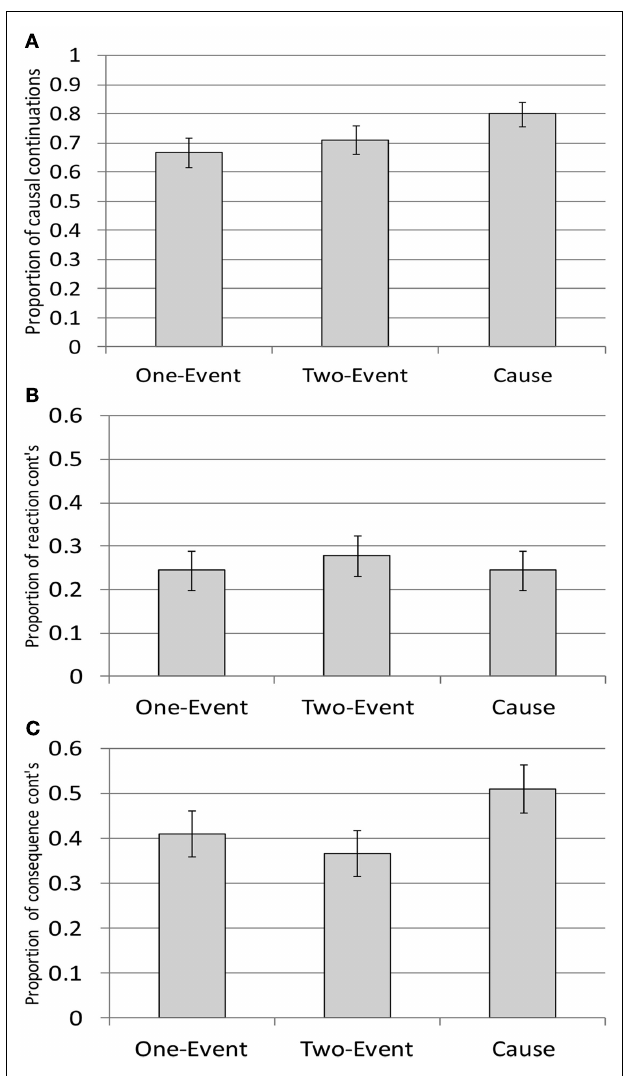
FIGURE 2 | (A) Proportion of causal continuations as a function of the three different kinds of prime actions. (Error bars show ± 1 SE). (B) Proportion of reaction-type continuations as a function of the three different kinds of prime actions. (Error bars show ± 1 SE). (C) Proportion of consequence-type continuations as a function of the three different kinds of prime actions. (Error bars show ± 1